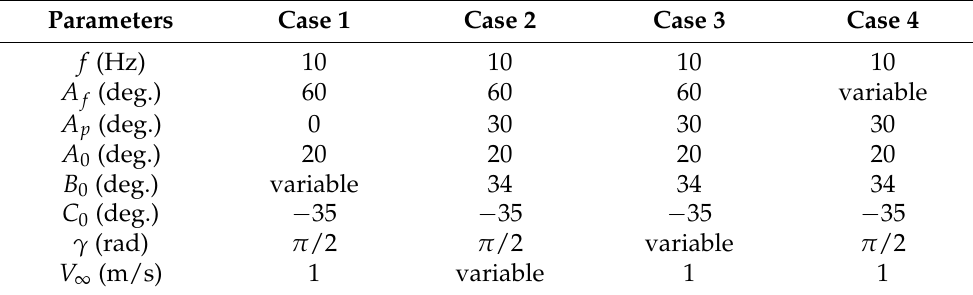
Table 5. Kinematic parameters K set-ups of four cases.